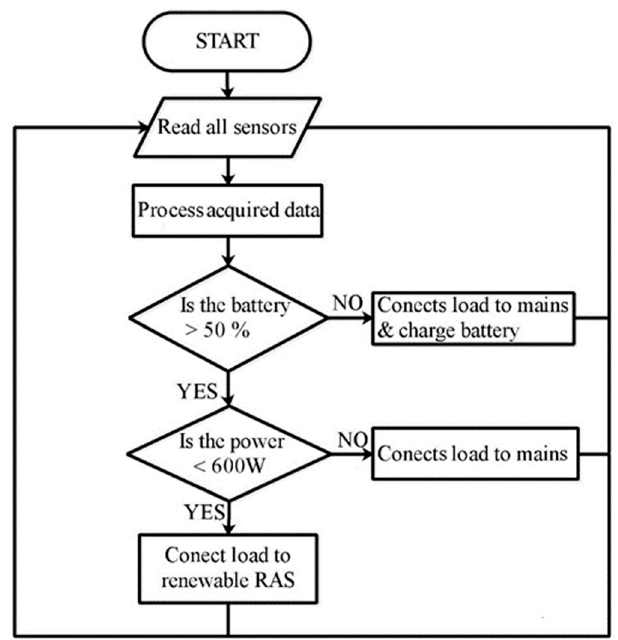
Figure 8. Load control software algorithm.